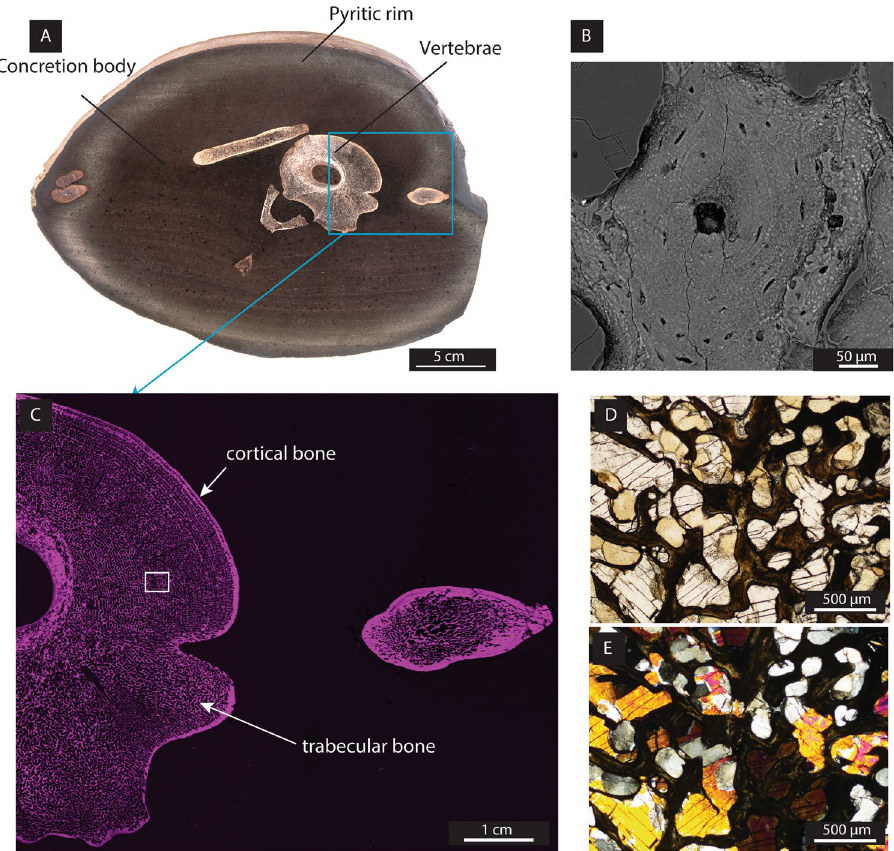
Figure 1. Morphology, mineralogy and chemical composition of ichthyosaur bones within a carbonate concretion. ( A ) Photographic image of a polished section of the bone-containing concretion. The vertebra served as the main nucleus which triggered the microbial degradation processes leading to the concretion. The rim contains a high amount of pyrite (observed by XRD, optical microscopy and SEM) in contrast to the concretion body. ( B ) Backscattered electron image of a Haversian system, including Haversian canal, osteocytes and lamellae from the bone. ( C ) Microbeam XRF elemental mapping of phosphorus (magenta) showing that phosphorus is relatively more abundant in the bones than in the concretion. The blue square represents the area where the Haversian system was imaged. ( D and E ) Optical imaging on a thin section using ppl ( D ) and xpl ( E ) showing the minerals filling the porosity of the bone: equant sparry calcite (CaCO 3 ) and barite (BaSO 4 ). BaSO 4 was identified by its mineral properties (clear colour and 90° cleavages) and high birefringence as well as by elemental distribution using microbeam XRF (Figure